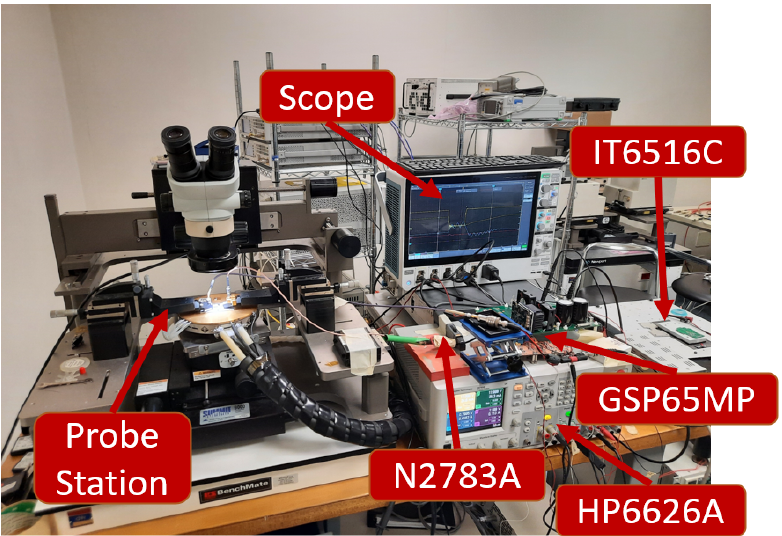
Figure 5. Picture of the reconfigurable setup for dynamic R ON measurement in the